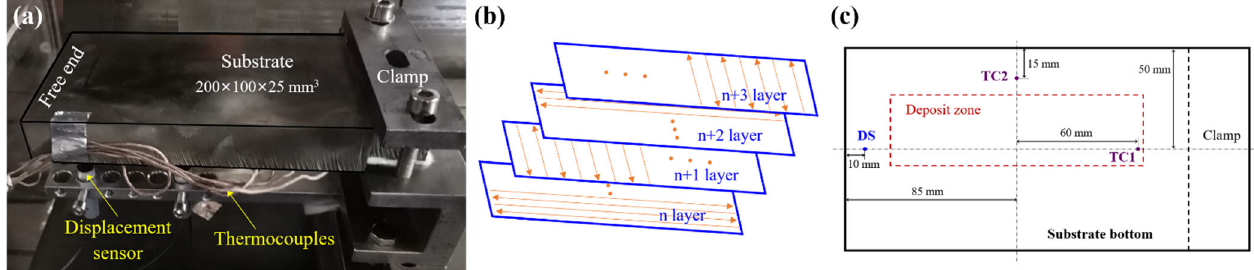
Figure 1. DED process: ( a ) in situ experimental set-up; ( b ) scanning path used; ( c ) locations of two thermocouples (TC1-TC2) and one displacement sensor (DS) at the bottom surface of the substrate.